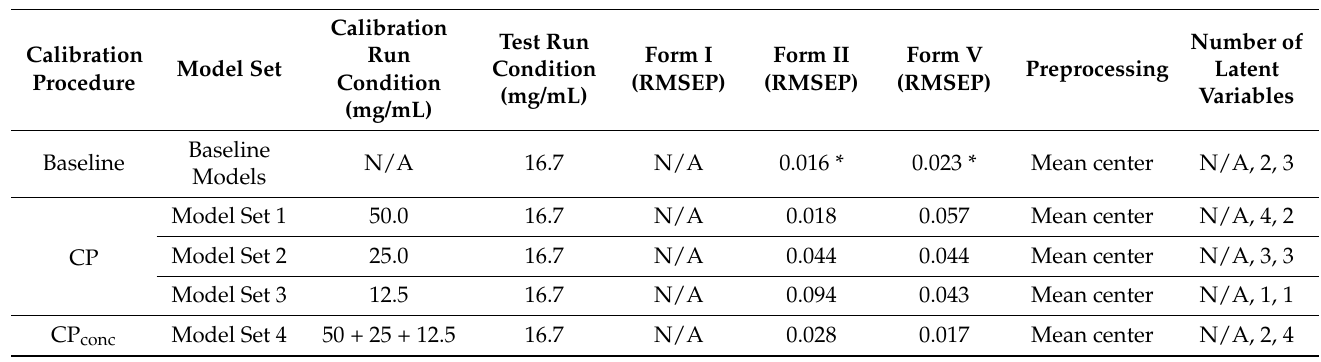
Table 3. Prediction performance of each model generated for the maleate acid salt experiments. Note that the % relative standard deviation of Raman quantitation was approximately 1.12%, and all models had R 2 >